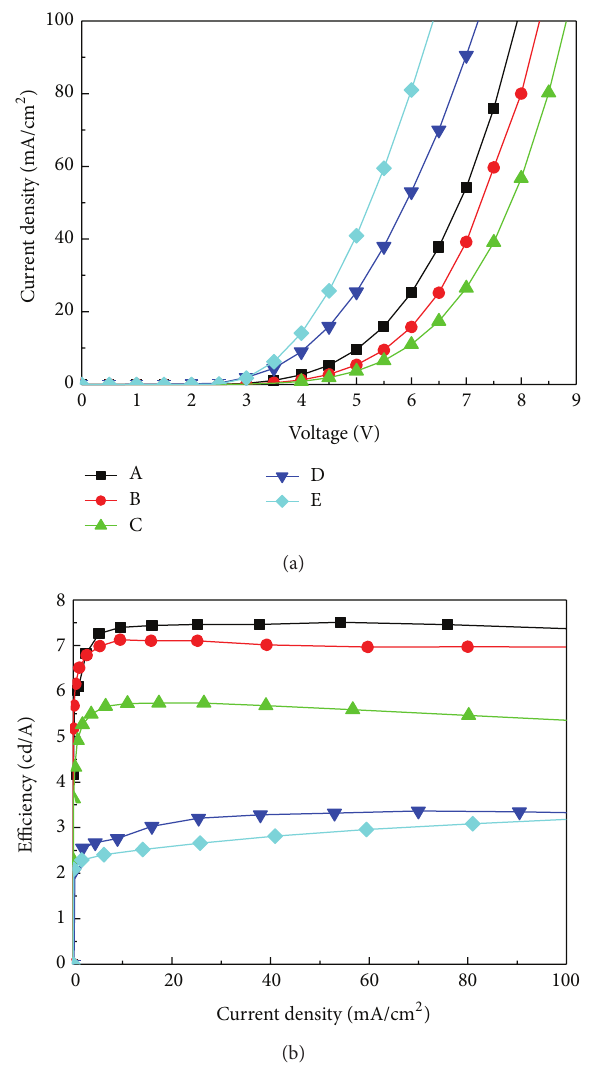
Figure 1: (a) Luminance versus bias voltage and (b) electrolumines- cence efficiency versus current density of devices A to